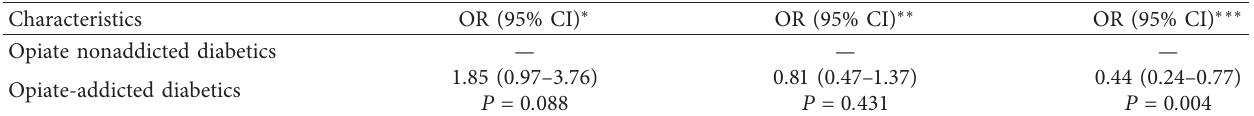
Table 3: Logistic